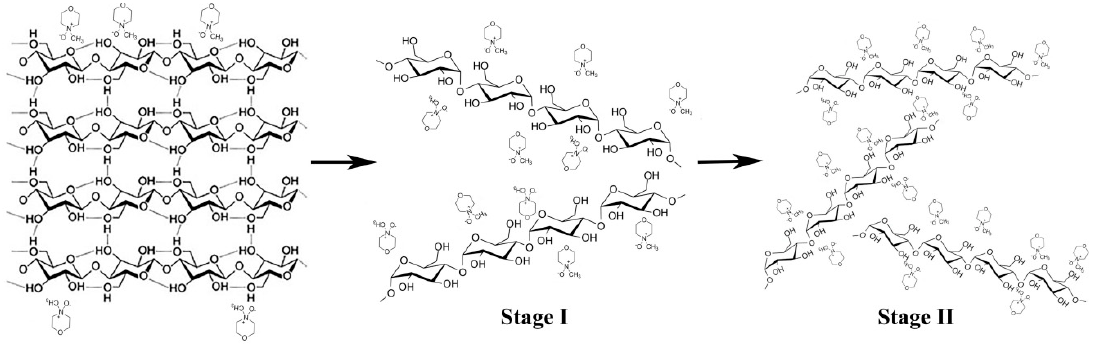
Figure 2. Schematic representation of the stages of interaction of NMMO with cellulose.